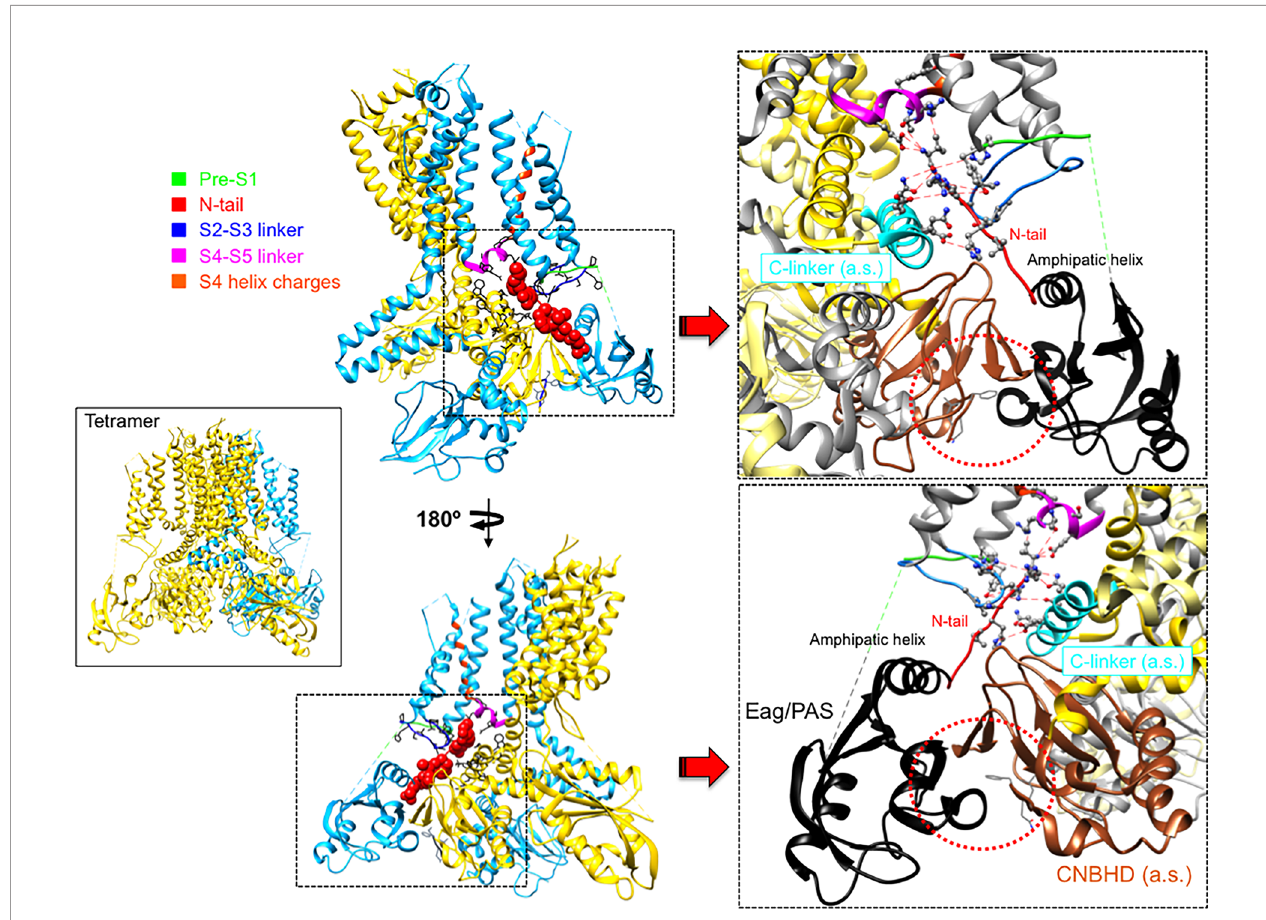
FIGURE 4 | Close apposition of the erg1 (Kv11.1) N-tail with other cytoplasmic linkers of the channel and possible network of interactions that may dynamically contribute to modulate channel gating. Left. Lateral view of the erg1 tetrameric structure (Wang and MacKinnon, 2017; PDB code 5VA2) shown with ribbons. A highlighted subunit is colored in blue. Center. View of only two adjacent subunits in which some domains of the blue subunit are colored as indicated at the left high corner. Atoms corresponding to the amino terminal N-tail (red) are shown as spheres. Lateral chains of selected residues surrounding the space(s) around the N-tail position, pertaining to the pre-S1, S2 – S3 and S4 – S5 linkers of the same subunit, and the C-linker of the adjacent subunit, are presented as black sticks. Grey sticks at the bottom correspond to the residues that constitute the intrinsic ligand of the cyclic nucleotide-binding homology domain (CNBHD), occupying the ligand- binding pocket analogous to where cyclic nucleotides bind to the cyclic nucleotide binding domains in other channels. Right. Enlarged views of the regions inside the squares delimited by black dotted lines are shown. Lateral chains of selected residues protruding from structure ribbons are shown as ball and stick with oxygen and nitrogen atoms as red and blue small spheres, respectively. Ribbon sections are colored red (N-tail), green (pre-S1), blue (S2-S3 linker), magenta (S4 – S5 linker) and cyan (C-linker of the adjacent subunit). Red dashed lines indicate interatomic distances ranging between 3.0 and 6.0 Å. Black and brown colors are used for ribbons corresponding to the P er- A rnt- S im (PAS) domain, and the CNBHD of the adjacent subunit ( a.s. ), respectively. Red dotted circles are used to mark the close proximity of these domains and the location of the CNBHD intrinsic ligand (gray sticks) toward the PAS domain surface. Structures were processed with UCSF Chimera (Pettersen et al.,